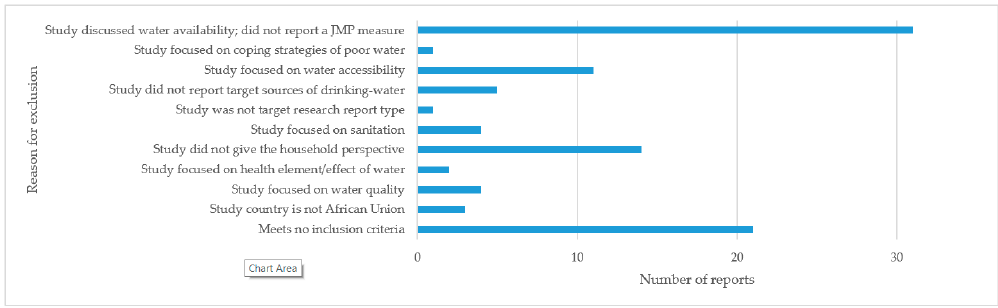
Figure A2. Reasons for studies being excluded at the characterisation stage.